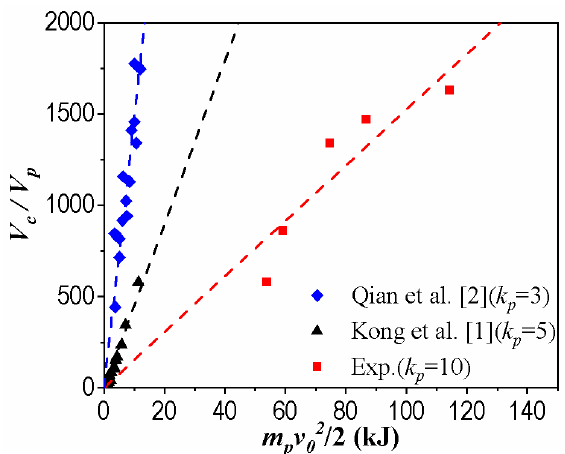
Figure 8. Non-dimensional crater volume vs. the projectile kinetic energy.